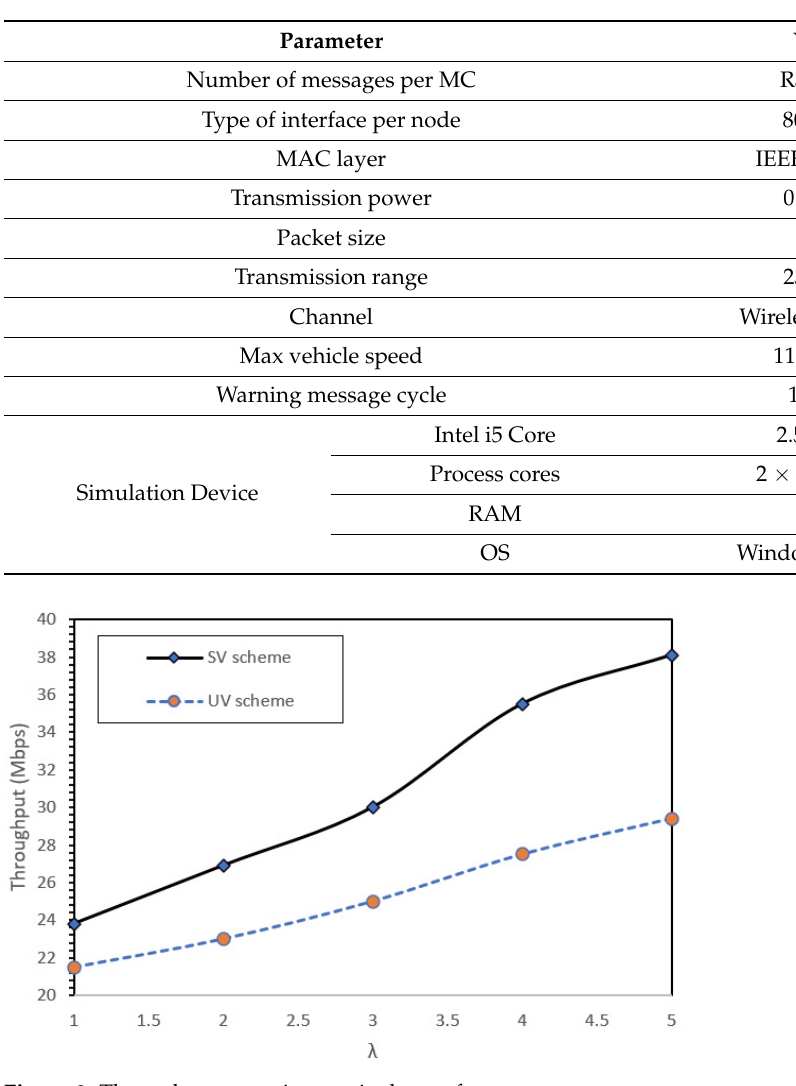
Figure 2. Throughput at various arrival rates for requests.